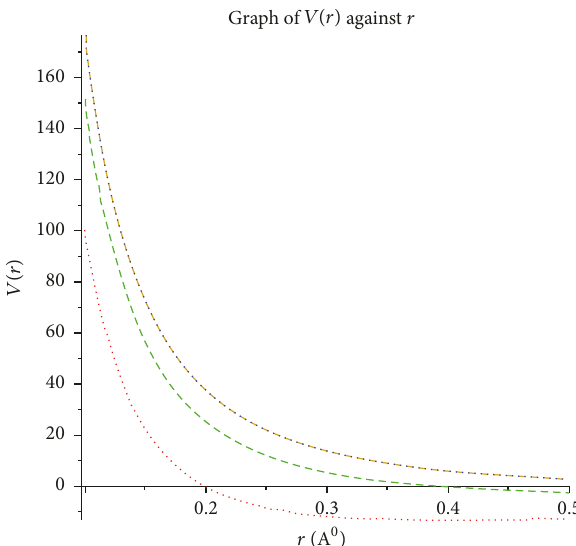
Figure 1: The graph of the quantum interaction potential (HYIQP) for various value of 𝛼 .